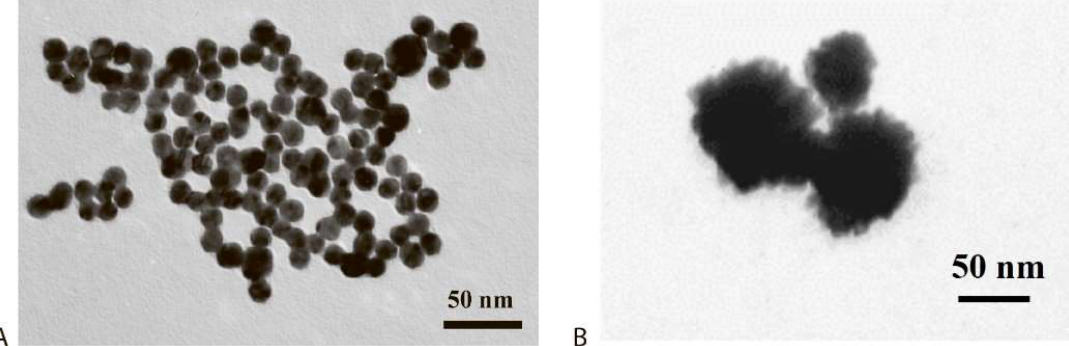
Figure 5. GNFs preparation: TEM images of the nuclei ( A ) and the final GNFs ( B ).